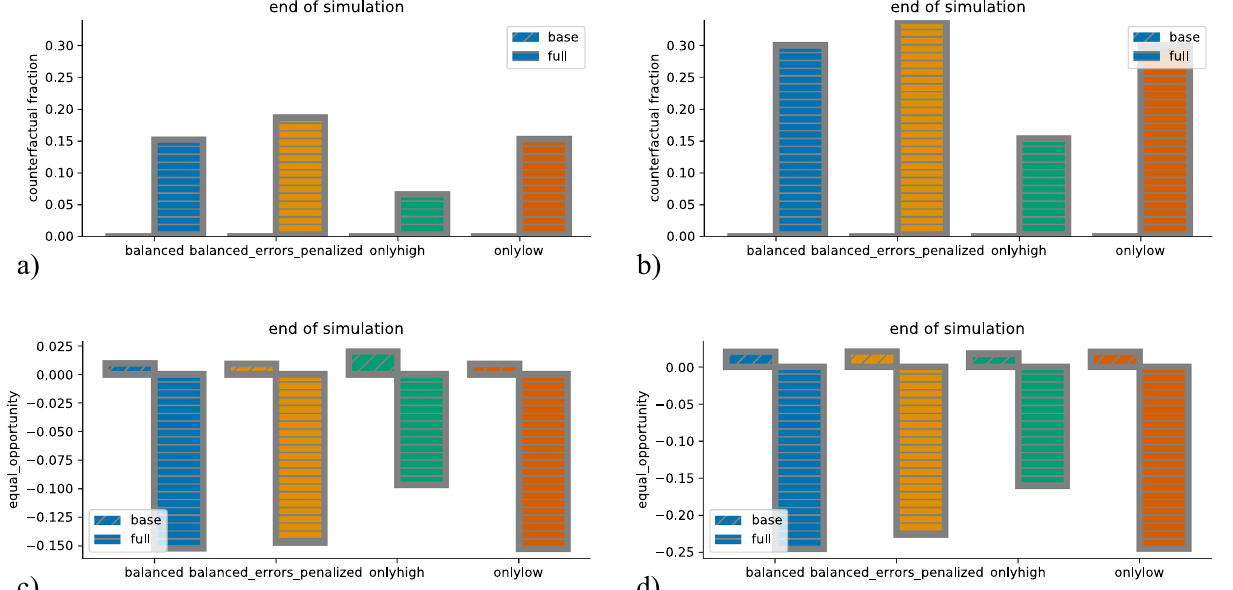
Figure 6. ( a , b ): Counterfactual fraction at the end of the simulations, for the unbiased ( a ) and biased ( b ) labor market. Different colors indicate different intervention scenarios, different hatching of the base (without protected attribute) and the full model (protected attribute). With the base prediction model, the counterfactual fraction is always zero. With the full prediction model, it is always positive, and depending on the intervention scenario. ( c , d ):Equal Opportunity ( TNR priv − TNR upriv ) at the end of the simulations, for the unbiased ( c ) and biased ( d ) labor market. Positive values indicate a positive bias in favor of the privileged group, and negative values a bias in favor of the unprivileged